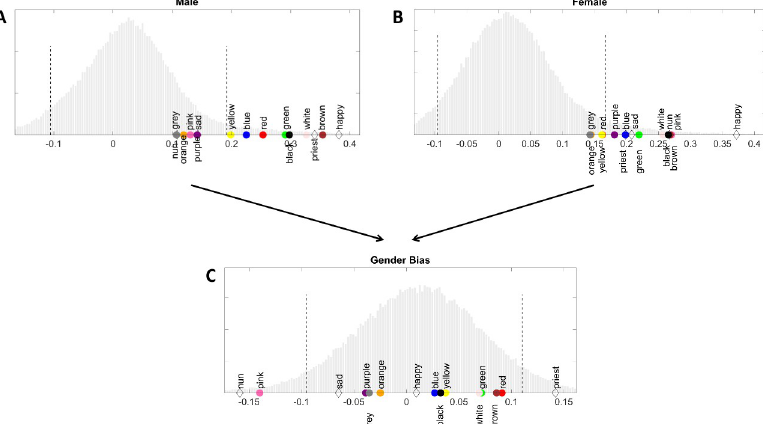
Fig 1. Gender bias. Distributions of similarity scores to the concepts of male (A) and female (B) well as gender biases (C) of colour terms, anchor words, and 100,000 most frequent words in our corpus. Colour terms and anchor words are marked with appropriate colours. Dashed lines indicate the 5 th and 95 th percentiles of the distributions (for exact values, see Table 1). https://doi.org/10.1371/journal.pone.0251559.g001 words priest and happy had higher similarities to the concept of male than 95% of the words in the normative word population (Fig 1A). Seven colour terms blue , green , pink , brown , white , black , purple and all anchor words had higher similarities to the concept of female than 95% of the words in the normative word population (Fig 1B). Notably, four colour terms, green , blue , brown , and black , and the anchor word happy had higher similarity scores to both concepts (i.e., male and female) than 95% of the words in the normative population. When interpreting gender biases (Fig 1C), the anchor word priest scored higher than 95% of the words in the normative word population, meaning it was biased towards masculinity. The anchor word nun and the colour term pink scored lower than 95% of the words in the Table 1. Similarity scores and biases. These are the similarity scores to the concepts of male, female, posemo, and negemo, as well as gender and valence biases of 11 col- our terms and four anchor words. The position of each score in relation to the normative word population (i.e., 100,000 most frequent words) appears under “percentile”. Values in bold are below the 5th or above the 95th percentile, indicating extreme similarities or biases of these words (same data as in Figs 1 and 2).